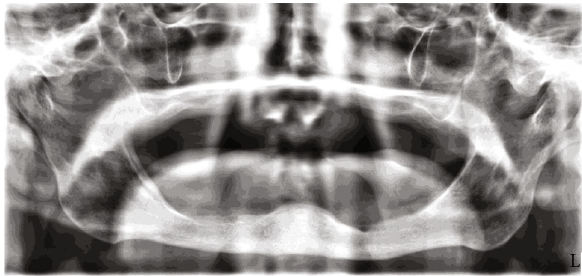
Figure 3: Orthopantomographic image showing no underlying bone resorption or